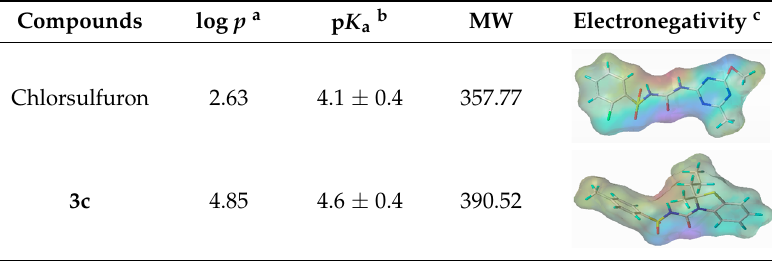
Table 3. Chemical property comparisons of chlorsulfuron with 3c .